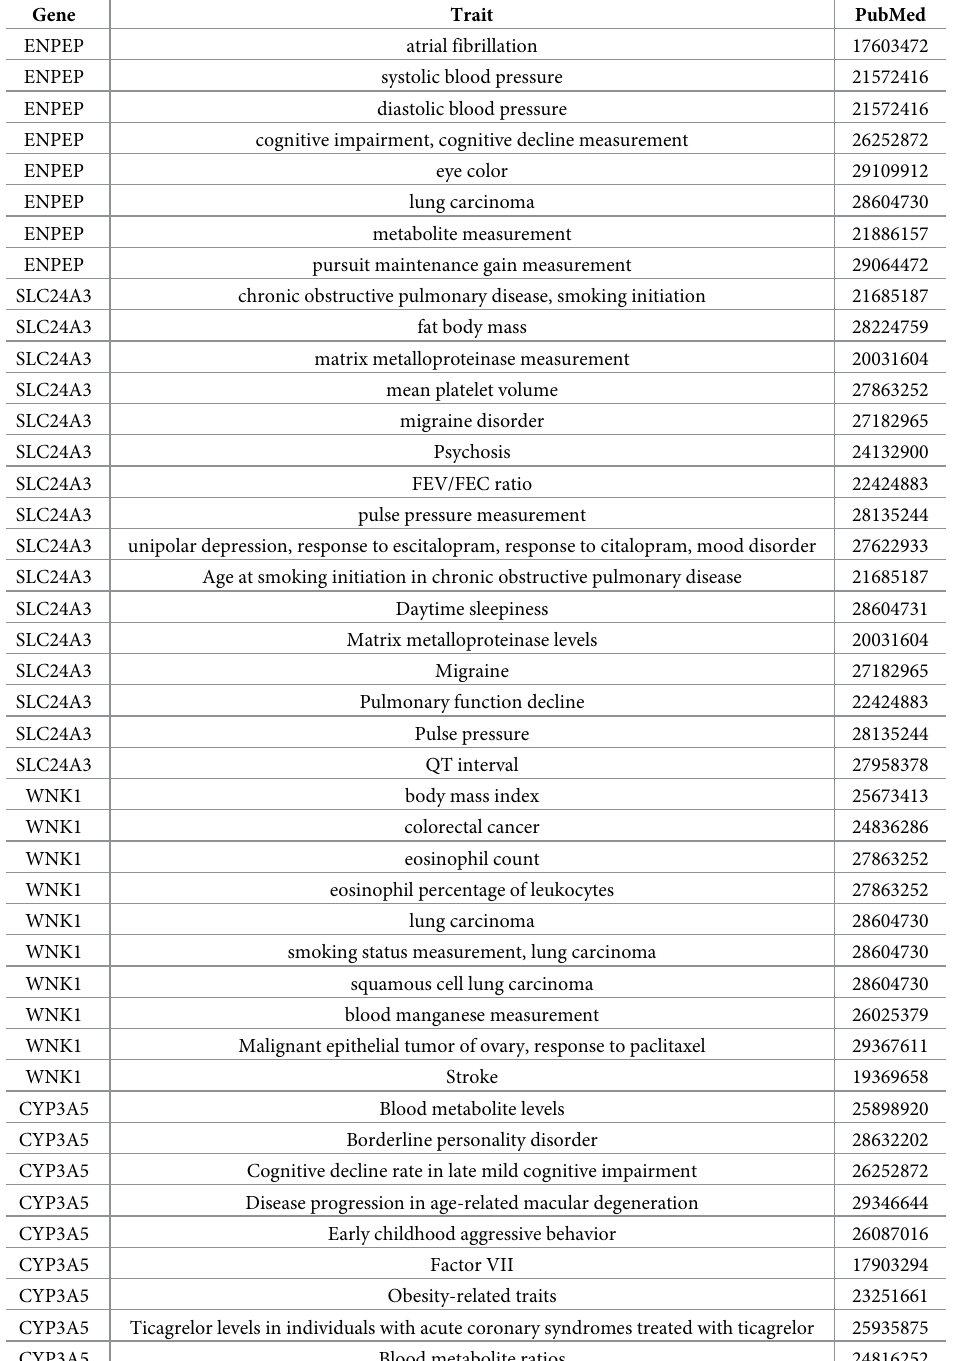
Table 7. The traits extracted from GWAS catalogue for the unreported genes co-expressed with obesity related genes. Gene Trait PubMed ENPEP atrial